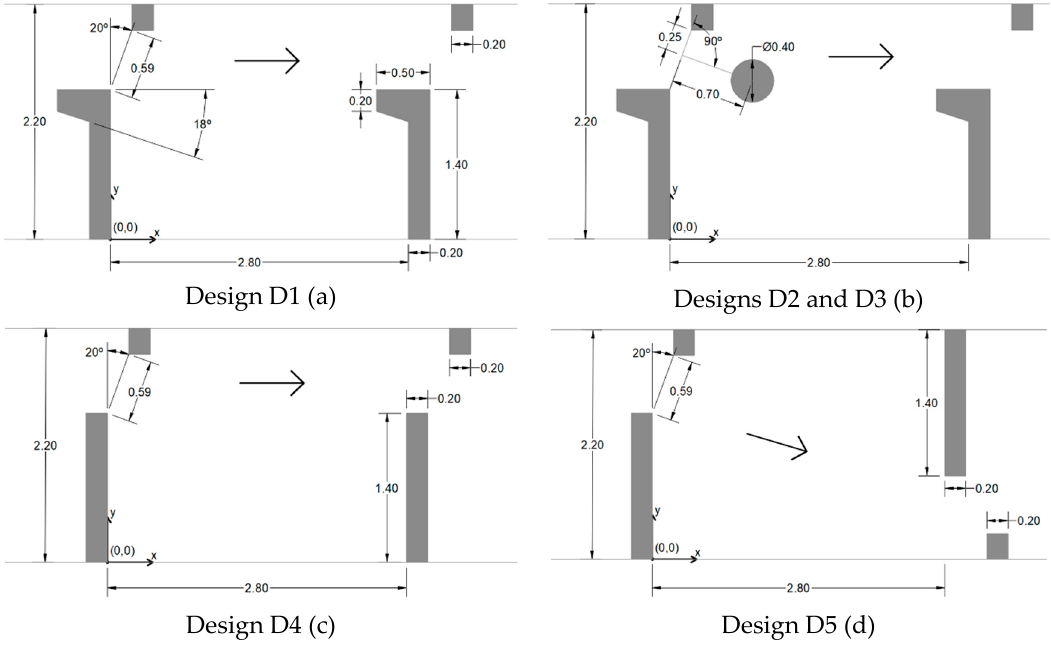
Figure 2. Plan views of fishway pools: ( a ) Design D1—reference; ( b ) Design D2 and D3—with cylinders; ( c ) Design D4—non-alternating straight baffles; ( d ) Design D5—alternating straight baffles (dimensions in